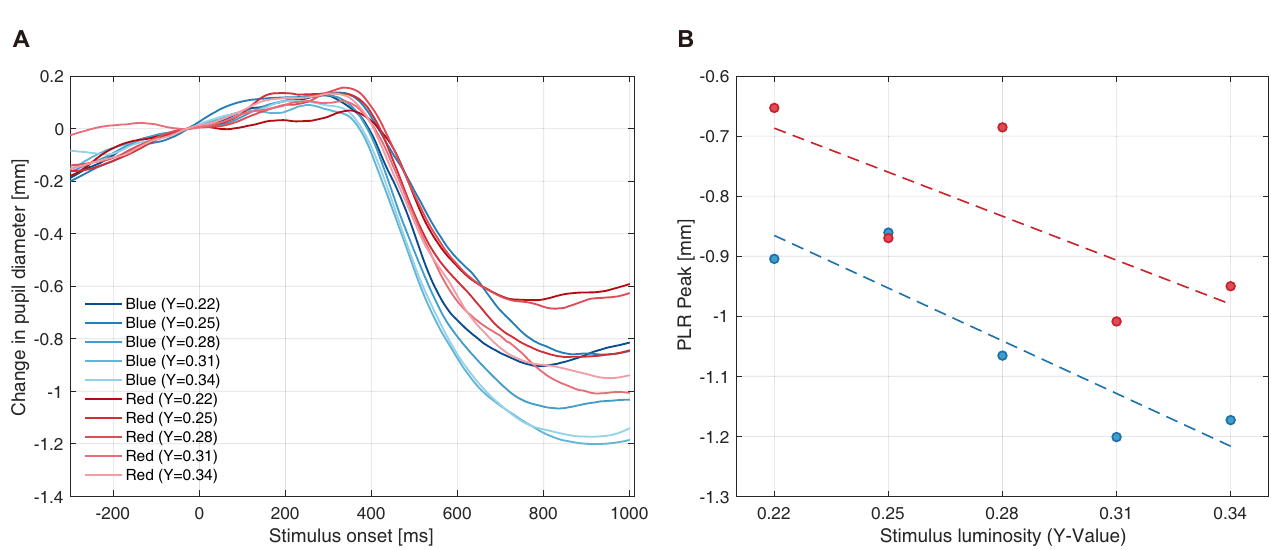
Fig 5. Example pupillary response and peak PLR amplitude. (A) One participant’s mean pupillary response to different hues and luminances (color and luminance: two (color) × five (luminance) = ten combinations). Solid lines represent pupillary responses for each condition. (B) An example of mean peak PLR amplitude for each color condition. PLR diameter is computed as the minimum pupil diameter. The two dashed lines represent the fitted linear regression model, composed of discrete luminance and peak PLR amplitude data points, for red and blue stimuli, respectively. Abbreviations: PLR–pupillary light